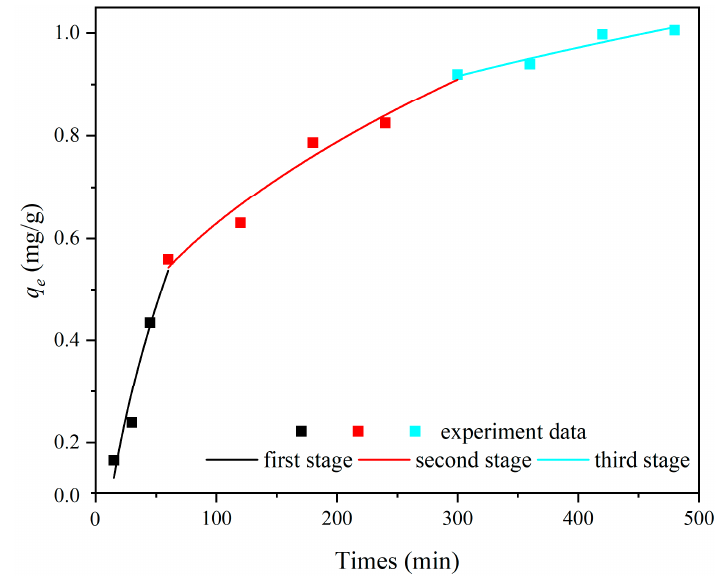
Figure 12. Intra-particle diffusion model for the adsorption of ammonium on bio-ceramsite. Table 7. Kinetic parameters using the intra-particle diffusion model for the adsorption of ammo- nium on bio-ceramsite.